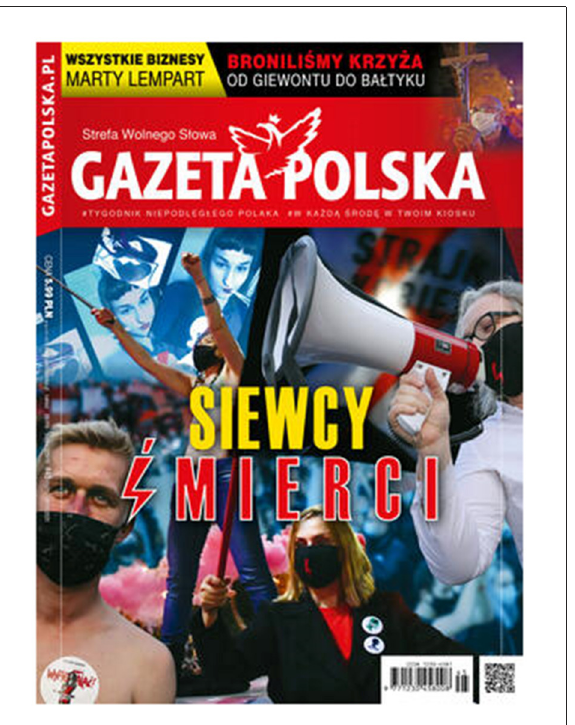
FIGURE2 The cover of Do Rzeczy , no. 51/2020 of December 2020. FIGURE3